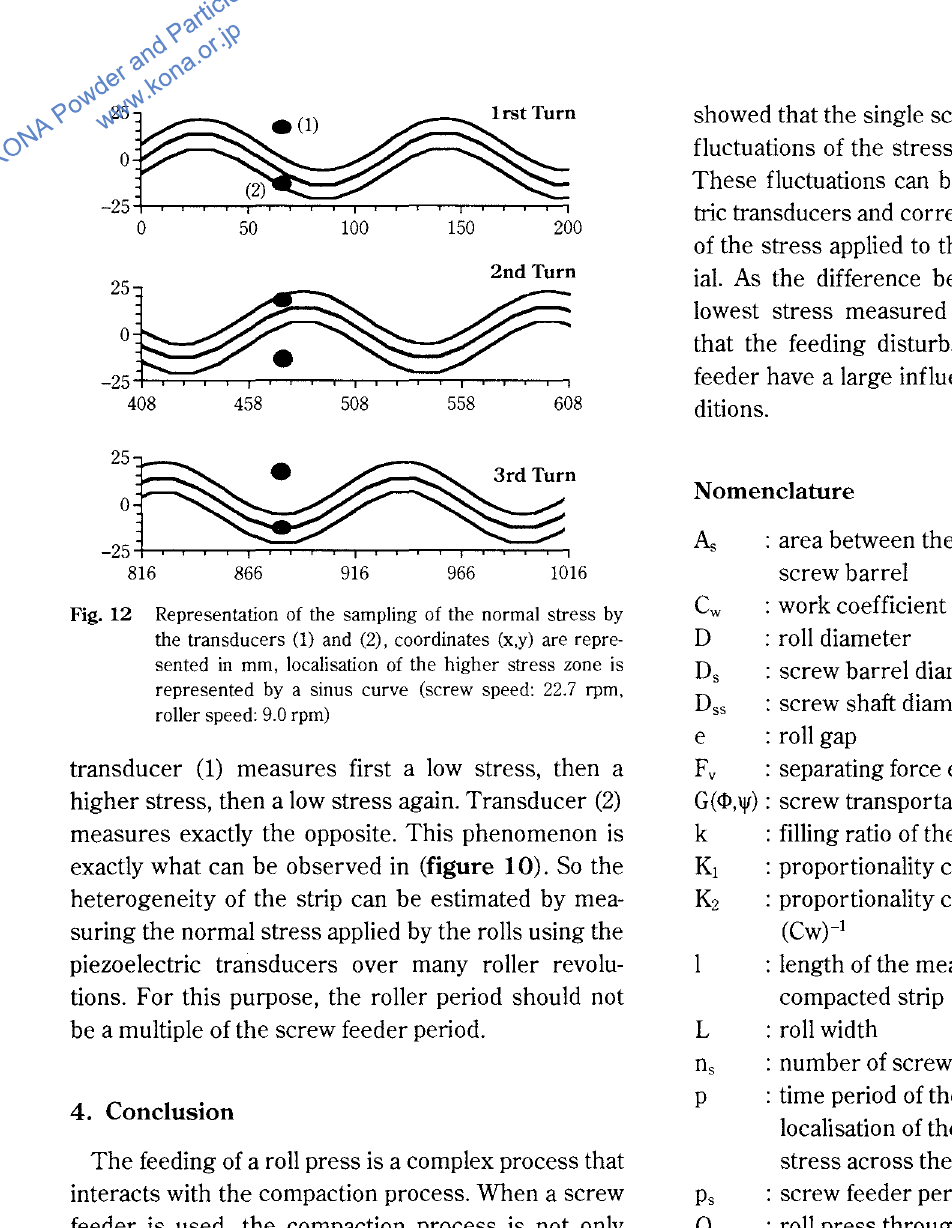
Fig. 12 Representation of the sampling of the normal stress by the transducers (1) and (2). coordinates (x.y) are repre· sented in mm, localisation of the higher stress zone is represented by a sinus curve (screw speed: 22.7 rpm, roller speed: 9.0